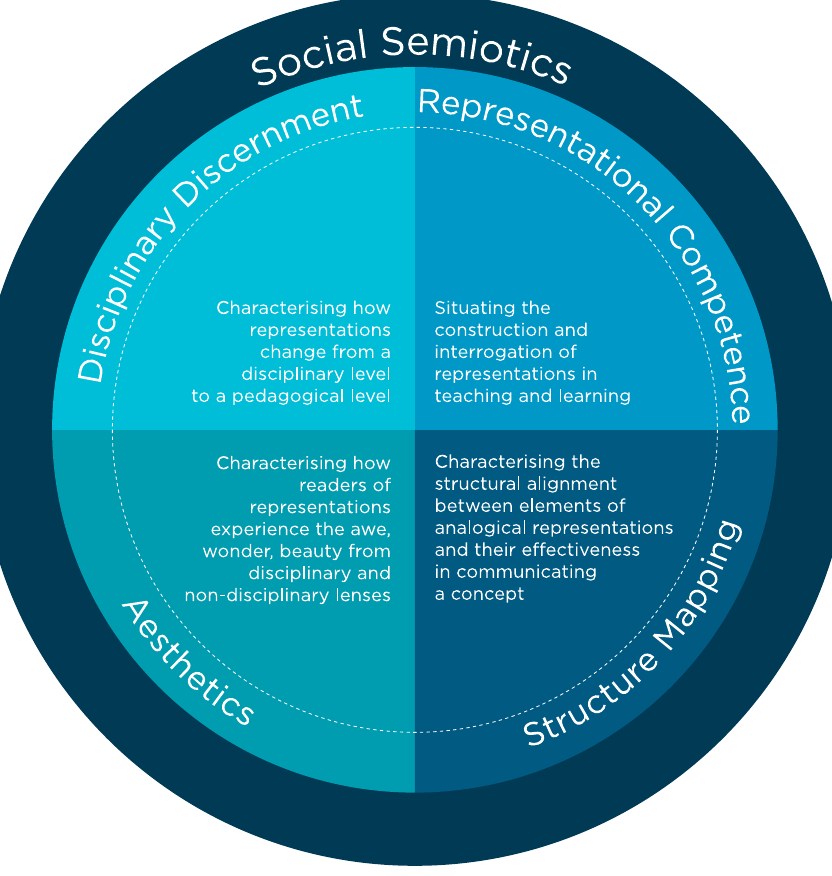
FIG. 2. The underlying conceptual framework of this study brings together four theoretical frameworks of disciplinary discernment, representational competence, aesthetics and structure mapping, within the overarching theoretical lens of social